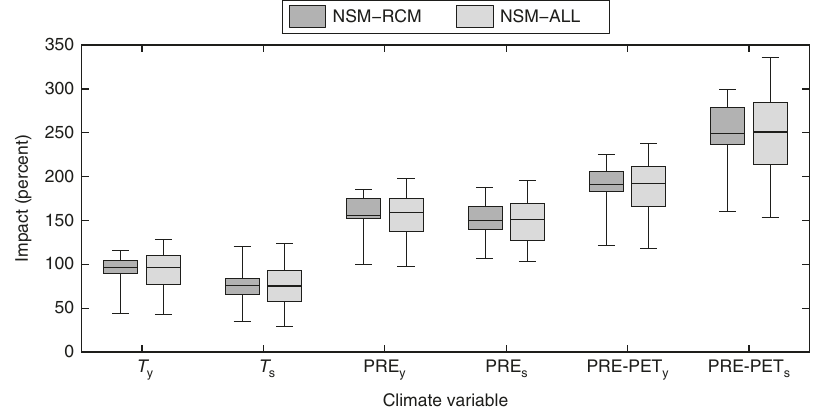
Fig. 5 Sensitivity analysis of the burned area changes in Mediterranean Europe for + 3 °C warming to the choice of the non-stationary model. Burned area changes (in %) are estimated considering the non-stationary model NSM (i.e., using Eq. 4) and several models with different climate variables (Table 1). Boxplots also show the uncertainty from the ensemble of RCM projections (NSM-RCM) and accounting for both RCM and regression model uncertainties (1000 bootstrap replications × the ensemble of RCMs; NSM-ALL). The median is shown as a solid line, the box indicates the 25 – 75 percentile range, while the whiskers show the 2.5 – 97.5 percentile